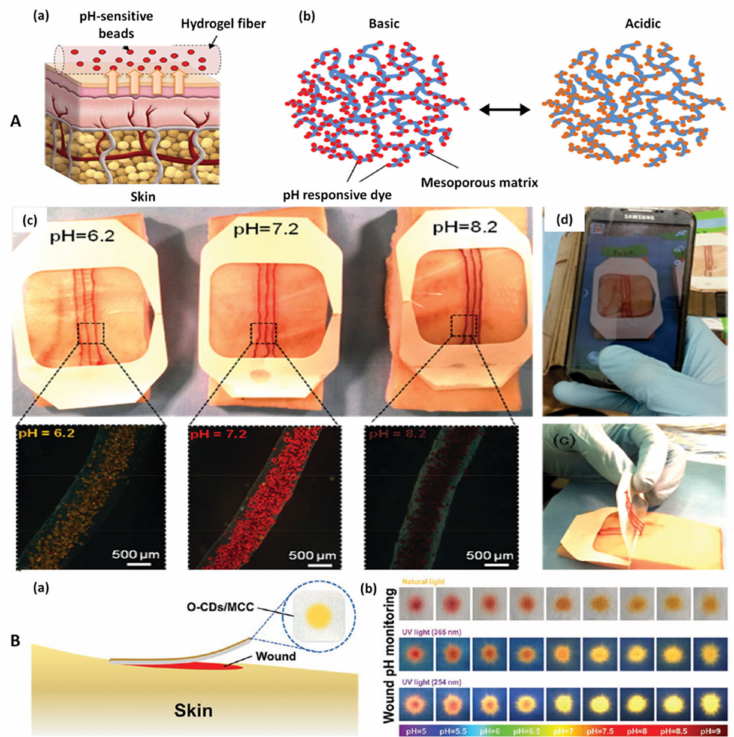
Figure 4. ( A ) Fabrication of pH-sensing microfibers. A schematic illustration of the pH-sensing hydrogel microfibers designed for long-term epidermal monitoring ( a ) and the action mechanism of the mesoporous polyester particles containing pH-responsive dye with electrostatic interaction to the solid matrix of the mesoporous particles ( b ). Fabricated wound dressings are placed on pieces of pig skin sprayed with solutions of different pH. The images confirm sufficient visual difference for identifying the variation in the skin pH for the range relevant to the values in chronic wounds. The insets are showing the images of the engineered fibers in the corresponding solutions ( c ). Pictures taken using a smartphone for determining the pH of the substrate ( d ). Reprinted (adapted) with permission from Reference [42]. Copyright 2021 John Wiley and Sons. ( B ) Schematic and conceptual view of the orange-emissive carbon quantum dots immobilized on common medical cotton cloth (O-CDs/MCC) in practical application ( a ). Photographs showing color appearance under natural light and fluorescence images under UV light (excited at 365 and 254 nm) of the O-CD/MCC treated by buffer solution at different pH value ( b ). Reprinted (adapted) with permission from Reference [46]. Copyright 2021 John Wiley and